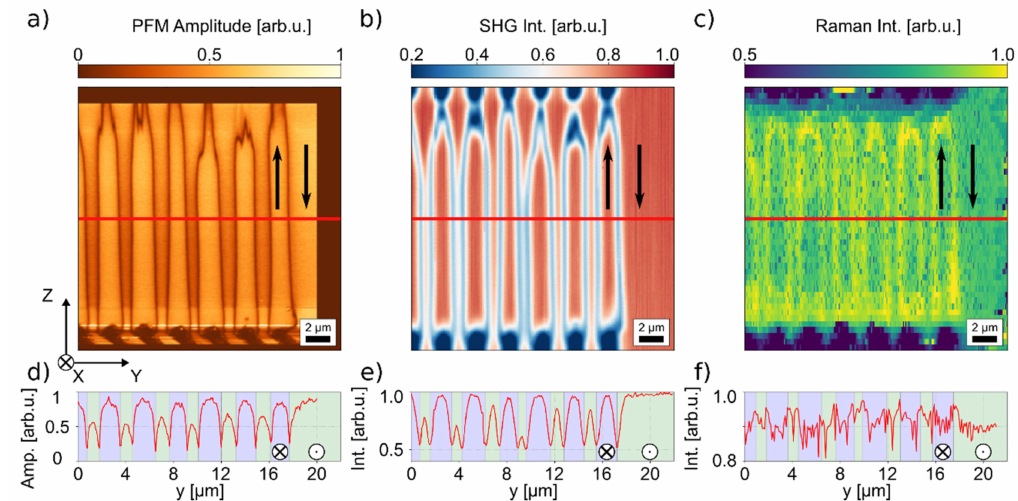
Figure 3. Periodically-poled thin film lithium niobate (PP-TFLN) in-plane ferroelectric domains imaged consecutively by ( a ) piezoresponse force microscopy (PFM), ( b ) second-harmonic generation (SHG), and ( c ) Raman spectroscopy (RS) over exactly the same sample area. Note the pronounced domain wall (DW) contrast by all techniques. The colormaps in ( d – f ) show cross-sections taken along the indicated red lines of the respective method ( a – c ). As a guide to the eye, green (pristine) and blue (inverted) domain areas mark the differently oriented domains. All measurements show the same domain pattern despite their different contrast